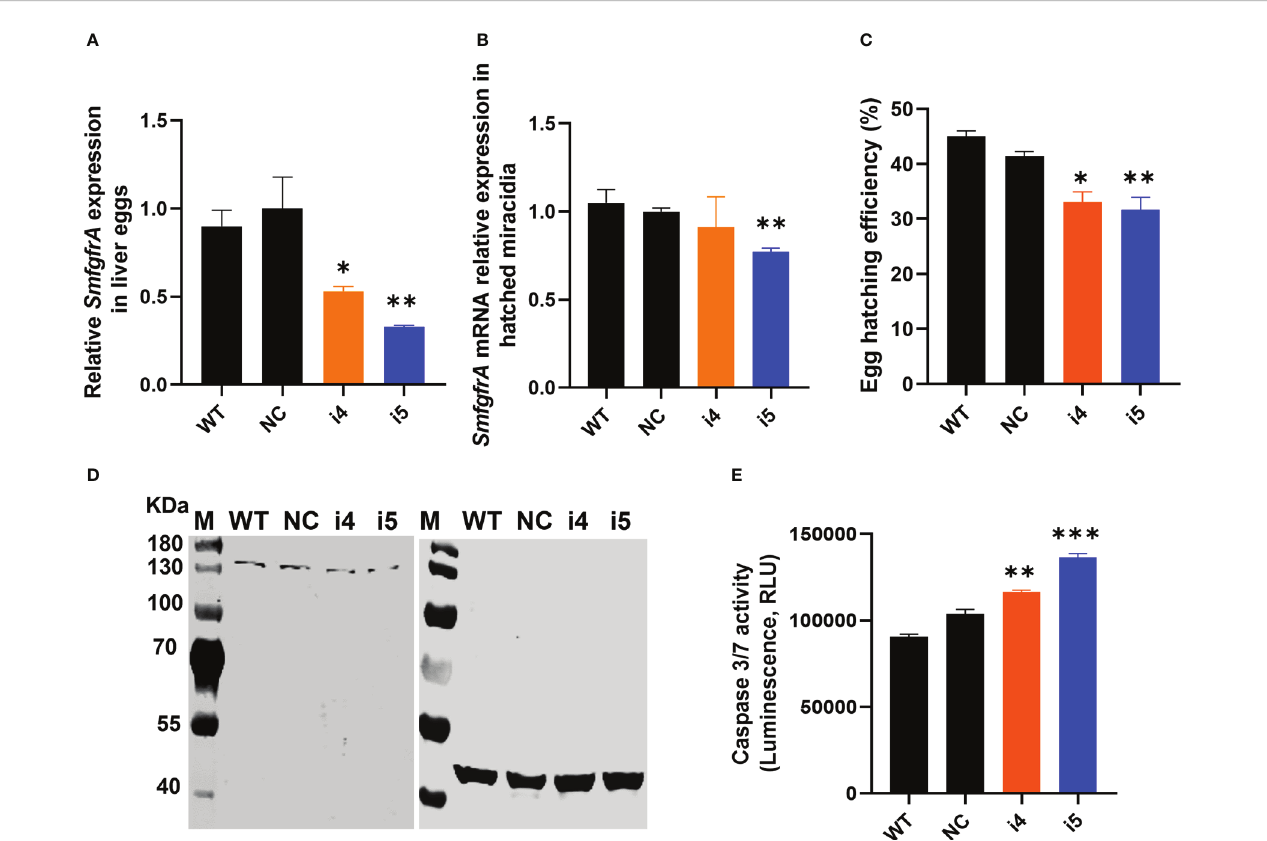
FIGURE 4 CRISPRi of SmfgfrA in S. mansoni eggs. (A) SmfgfrA mRNA level in eggs treated with i4 or i5. WT eggs and NC treated eggs were used as controls. (B) Transcription level of SmfgfrA in miracidia hatched from WT eggs and eggs treated with NC, i4 or i5. (C) Effects of SmfgfrA repression on the hatching of S. mansoni eggs. The hatching ef fi ciency (%) of WT eggs and eggs treated with NC, i4 or i5 was calculated by dividing the number of hatched eggs with the total number of eggs (hatched and unhatched) X 100. Experiments in panels (A – C) was performed in triplicates with all data presented as the mean ± SE. (D) Western blot showing expression level of SmFGFRA protein in SEA of WT eggs (Lane 1) and eggs treated with NC (Lane 2), i4 (Lane 3) or i5 (Lane 4). An anti-actin antibody was utilized as control to ensure equal loading. The electrophoresed SEAs were transferred for the western blot analysis to two PVDF membranes which were probed simultaneously with the anti-rSmFGFRA-L antibody (left blot) and the anti-actin antibody (right blot). (E) Caspase-3/-7 activity in soluble egg antigen (SEA) of WT eggs and eggs treated with NC, i4 or i5. This assay was conducted in duplicate with all data presented as the mean ± SE. * p value ≤ 0.05, ** p value ≤ 0.01, *** p value ≤